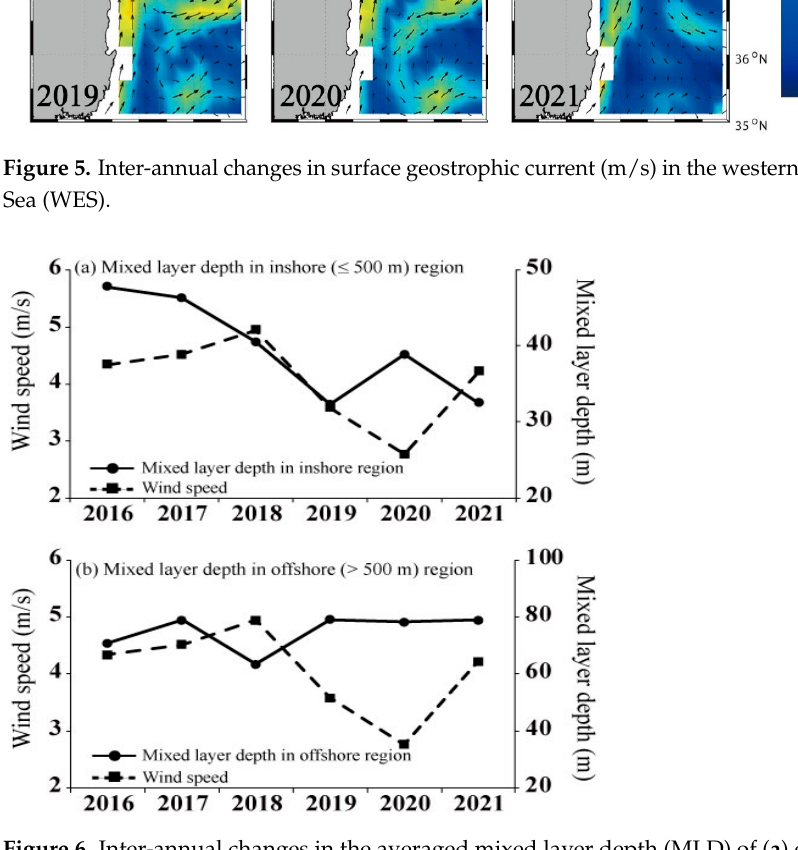
Figure 5. Inter-annual changes in surface geostrophic current (m/s) in the western part of East/Japan Sea (WES).